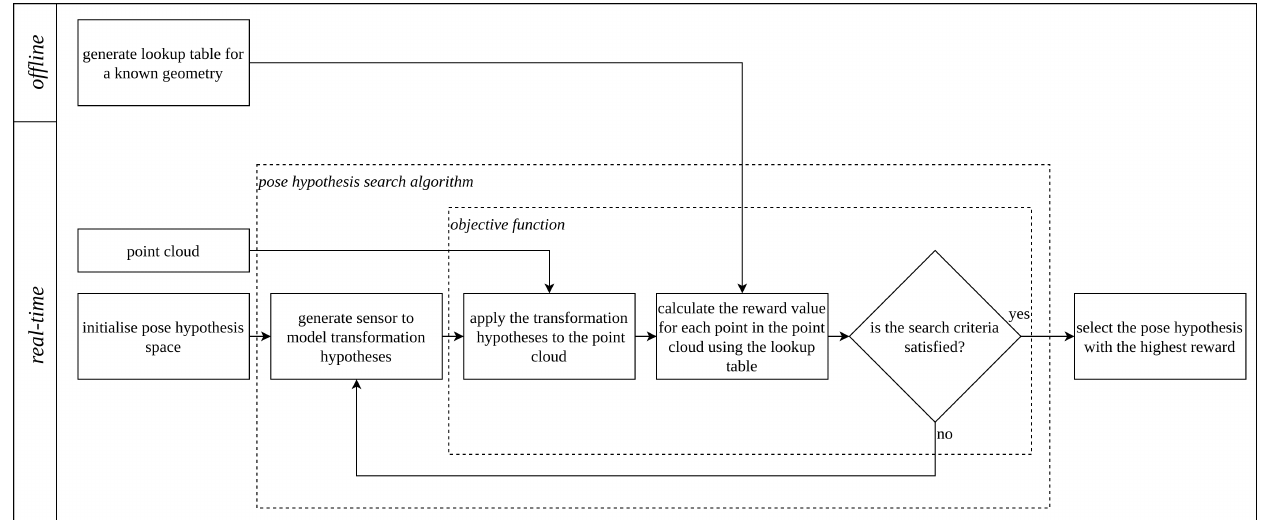
Figure 2. The model-based pose estimation problem is illustrated using a known geometry displayed in black and a point cloud in green. The goal is to determine the homogeneous transformation T ★ S→M that is most likely to reproduce the observed point cloud measurements.